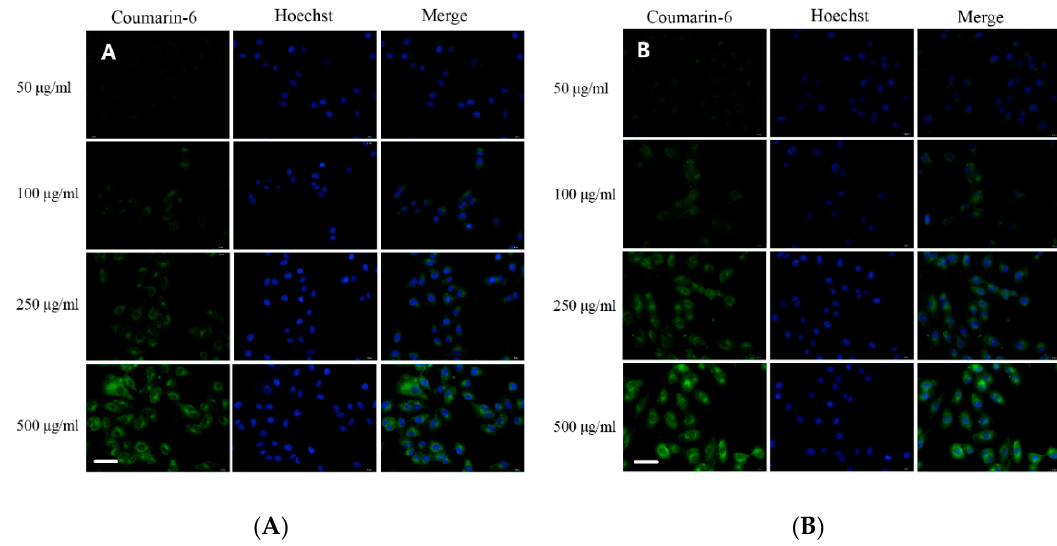
Figure 6. Fluorescence images of A549 cells after incubation with coumarin-6-loaded P407/PLGA NPs ( A ) and coumarin-6-loaded FCPP NPs ( B ). Scale bar = 20 μ m.